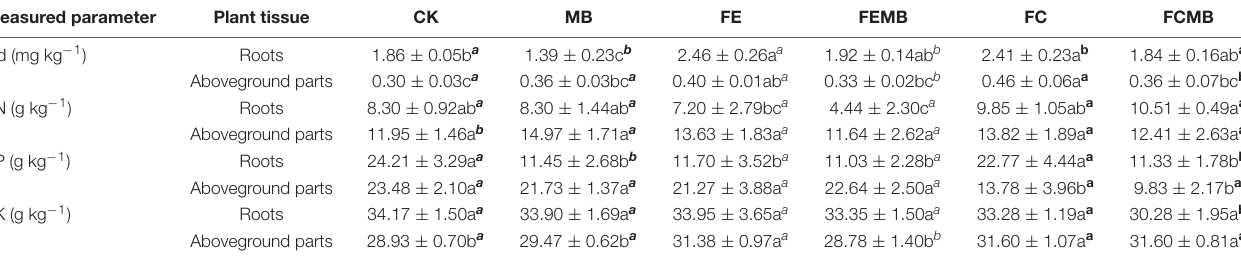
TABLE 1 | Contents of nitrogen, phosphorus, potassium, and cadmium in roots and shoots of Houttuynia cordata . Measured parameter